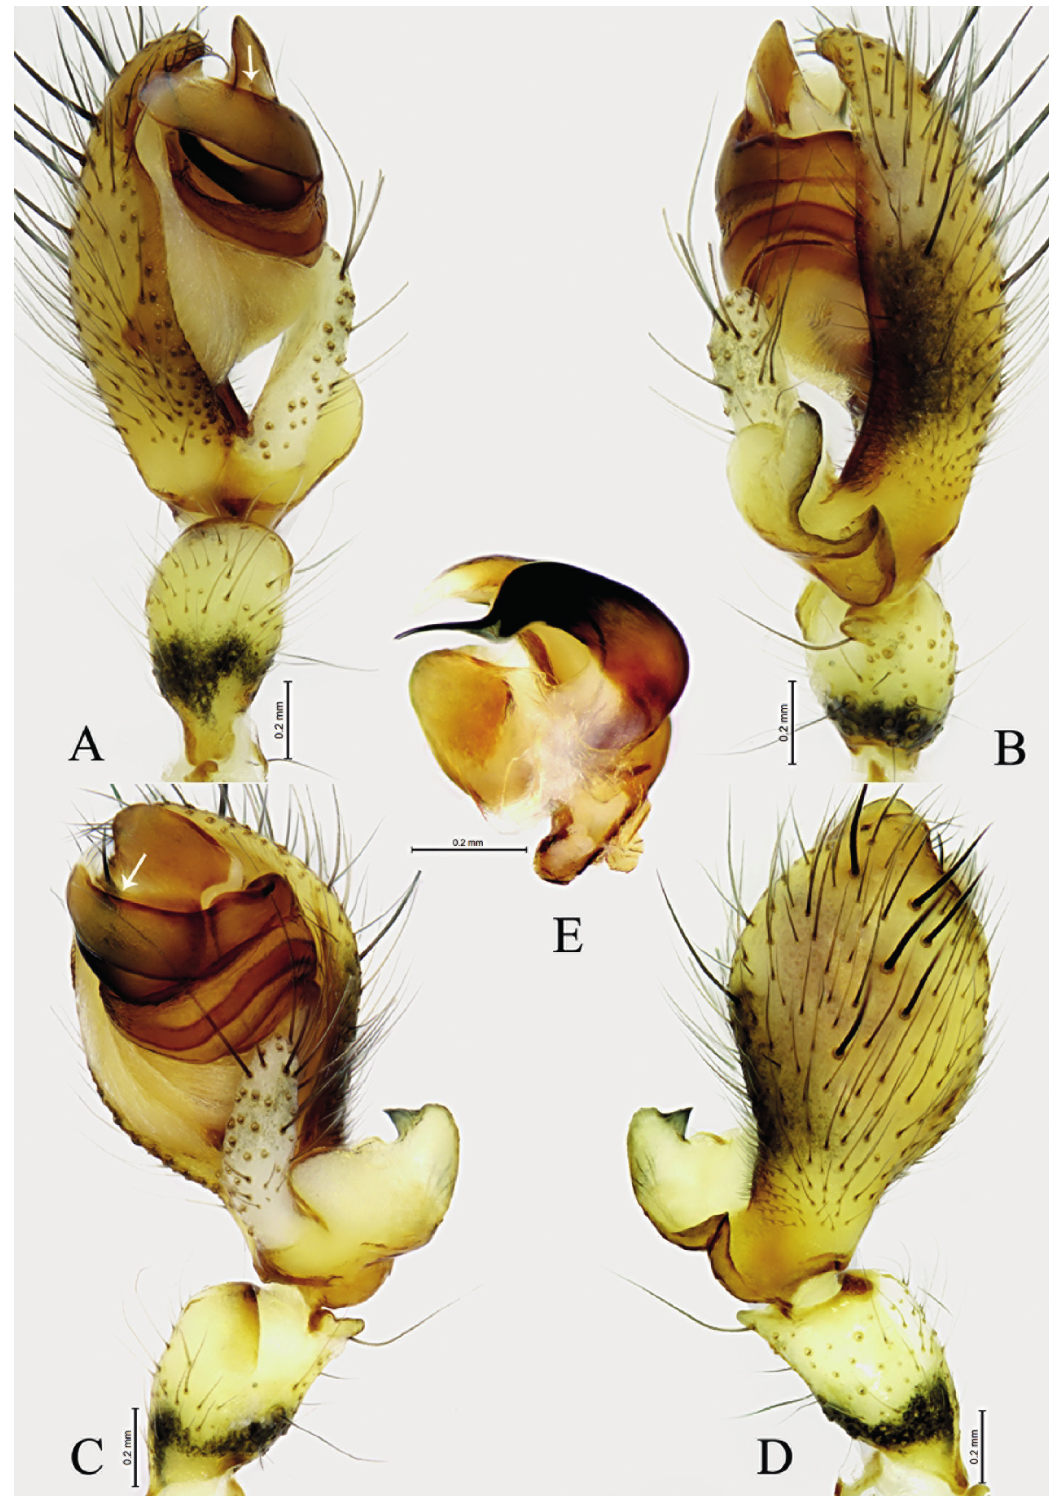
Fig. 6. Meta cona sp. nov., ♂, holotype (SWUC-T-TEg-03-01). A . Left palp, prolateral view. B . Same, ventral view. C . Same, retrolateral view. D . Same, dorsal view. E . Right palp, Embolus and metaine embolic apophysis, dorsal view. A, C . White arrow indicating the lower outgrowth of metaine embolic